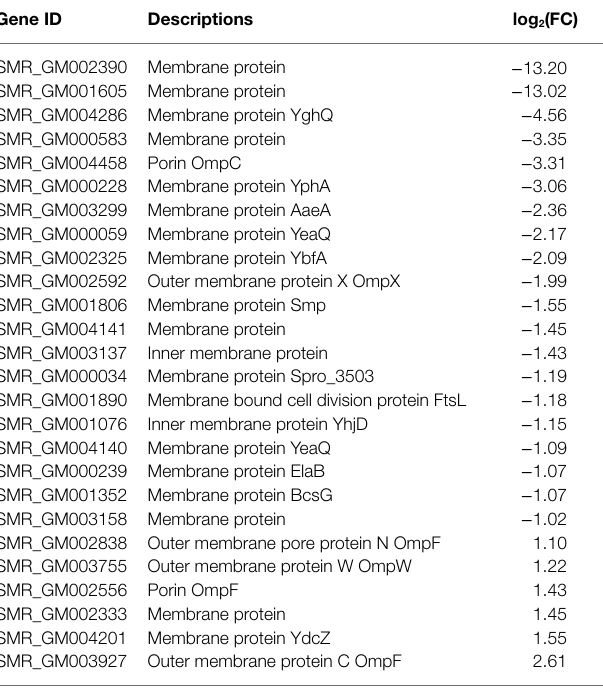
TABLE 3 | Membrane proteins in DEGs. TABLE 4 | Differentially expressed genes involved in type VI secretion system